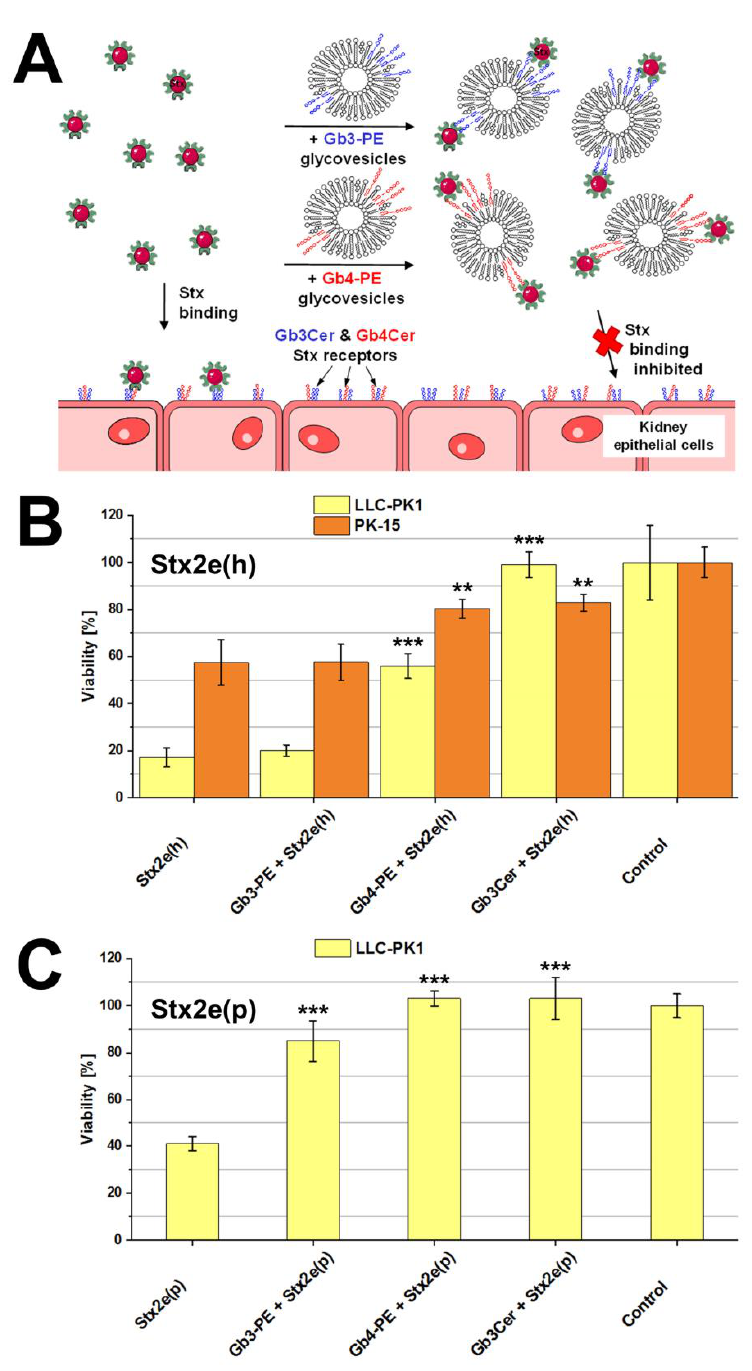
Figure 9. Scheme of attachment of Stx2e to the cellular receptors Gb3Cer and Gb4Cer, its interaction with Gb3-PE and Gb4-PE in the cell culture ( A ) and protective effect of the neoglycolipids towards porcine LLC-PK1 and PK-15 kidney epithelial cells exerted by Stx2e(h) ( B ) and Stx2e(p) ( C ). ( A ) Gb3-PE- and Gb4-PE-spiked glycovesicles were applied to block the binding of Stx2e towards Gb3Cer and Gb4Cer. ( B ) Stx2e(h) derived from a human STEC isolate and ( C ) Stx2e(p) from a porcine STEC isolate were solely applied or together with the neoglycolipids Gb3-PE and Gb4-PE or with authentic Gb3Cer (gold standard) as indicated. Cell survival was determined in relation to control cells cultured in medium without toxin corresponding to 100% viability. Significant differences of viability of cell cultures treated with Stx2e only (controls) or co-treated with Gb3-PE-, Gb4-PE- or Gb3Cer-spiked glycovesicles are indicated with asterisks (** p < 0.01; *** p < 0.001).